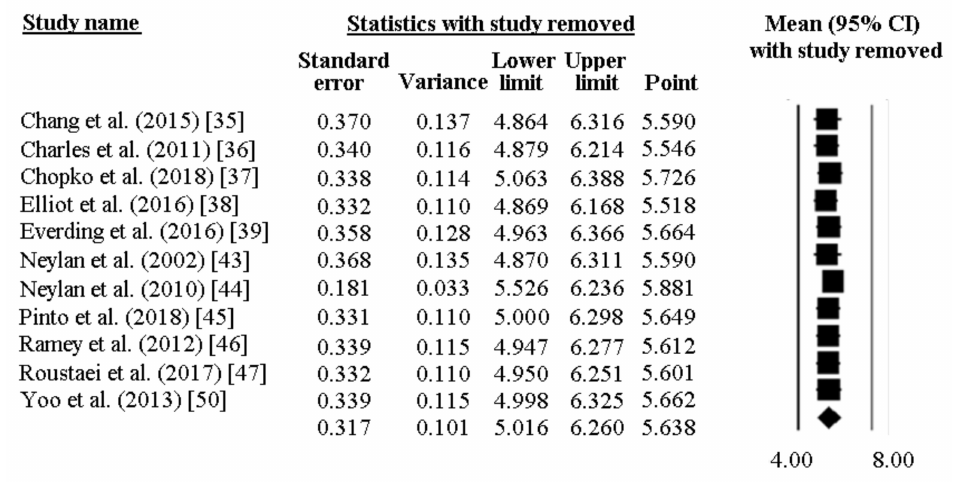
Figure 6. Pooled global score of PSQI in police officers.